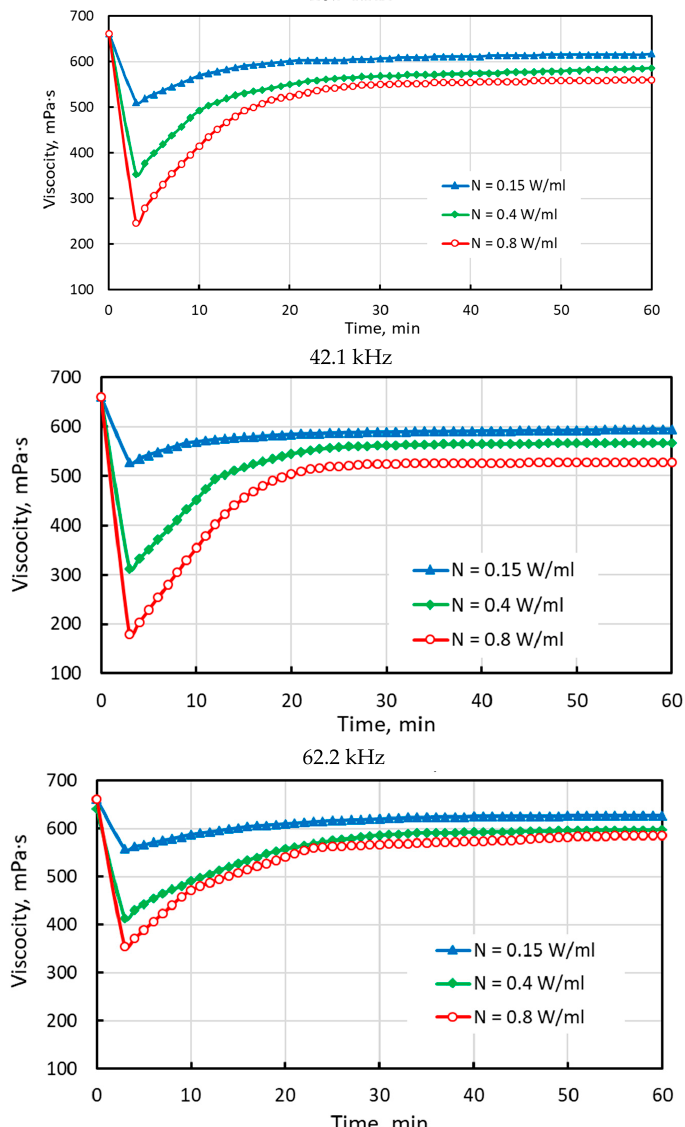
Figure 4. Dynamic viscosity of heavy oil sample versus relaxation time for different acoustic frequencies and powers. Sonication time was 3 min.